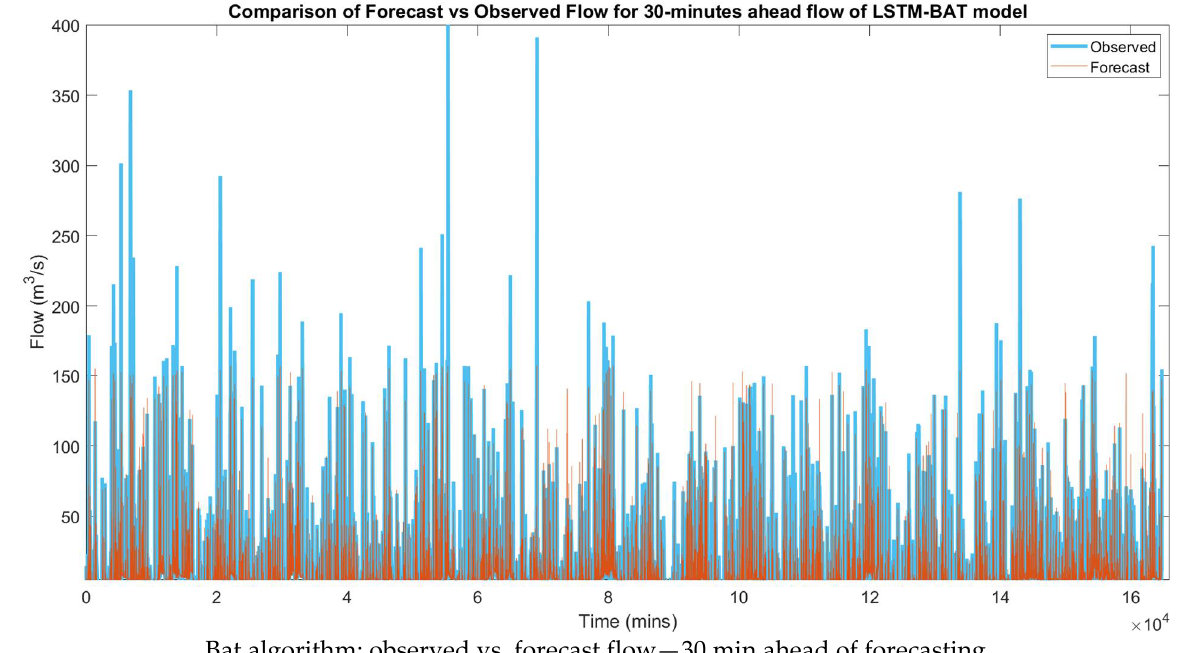
Bat algorithm: observed vs. forecast flow—30 min ahead of forecasting